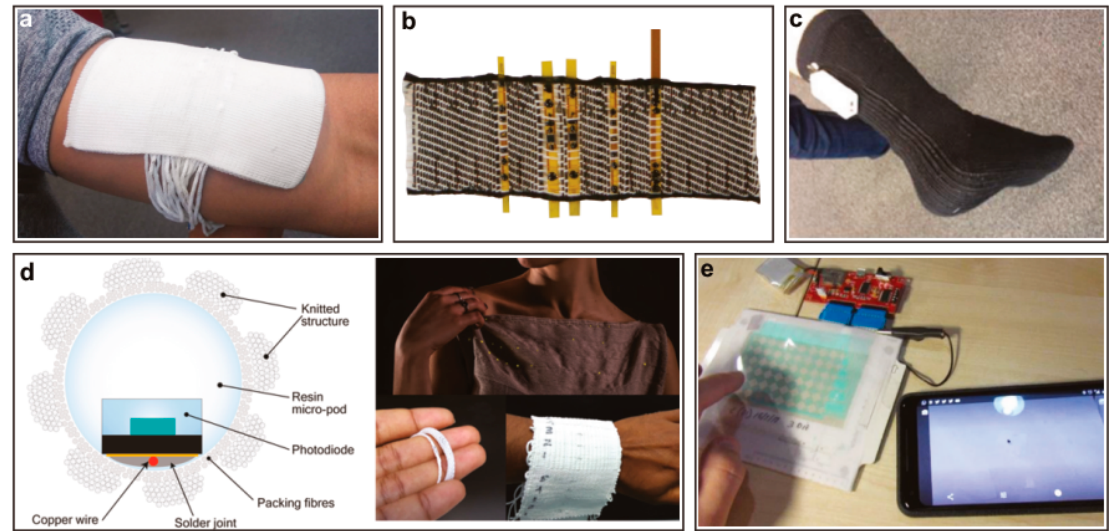
Figure 3. Examples for smart textiles and their applications [32]. ( a ) Temperature sensing yarns in a textile for health monitoring [45]. ( b ) Optoelectronic near-infrared spectroscopy smart textile for measuring the blood oxygenation levels in health care [46]. ( c ) A temperature-sensing sock for fitness and health care [47]. ( d ) Embedded photodiodes in textile for health-monitoring [48]. ( e ) Tactile-sensing fabric for applications in human-machine interfaces (HMIs), smartphones, and Internet of Things (IoT) devices [49].